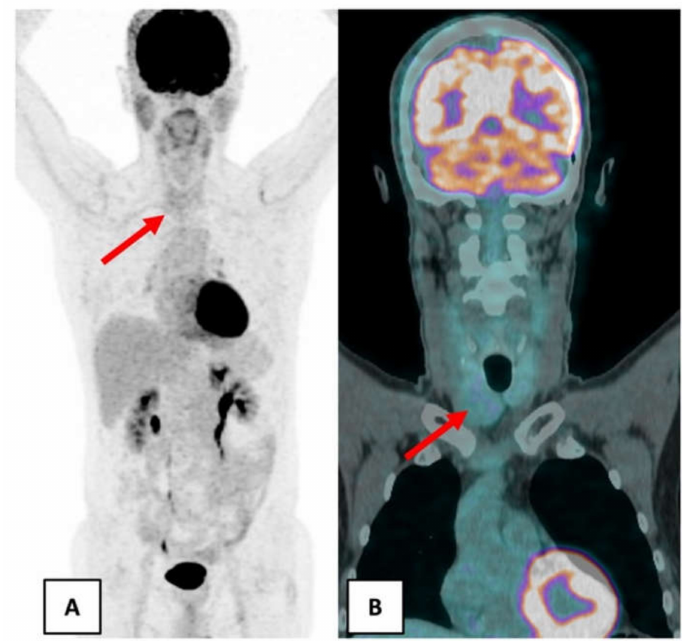
Figure 1. June 2018 18 F-FDG PET/CT showed a right lobar thyroid nodule without significant hypermetabolism (red arrow). ( A ) Maximum intensity projection. ( B ) Coronal fusion